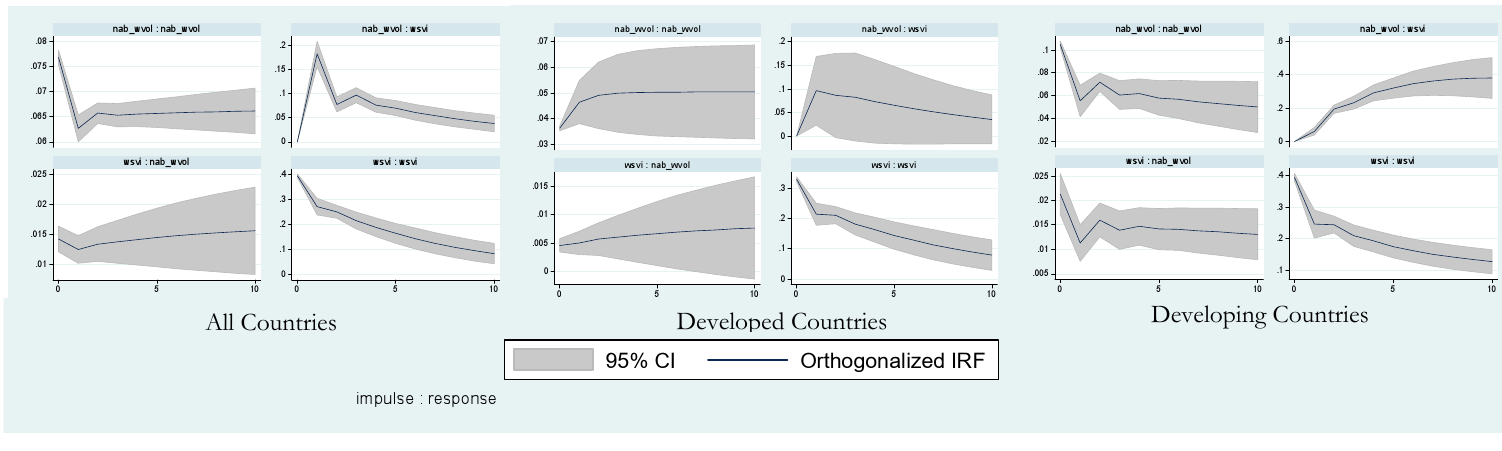
Figure 1. Orthogonalized impulse responses for the SVI relationships. Figure 1 depicts the impulse responses for the SVI–return ( A ), the SVI–volatility ( B ), and the SVI–abnormal trading volumes ( C ), respectively. From the left to right, each figure represents the impulse responses of the full sample, developed countries, and developing countries . The 95 % confidence interval ( CI ) is created by the Monte Carlo simulation with 500 repetitions.